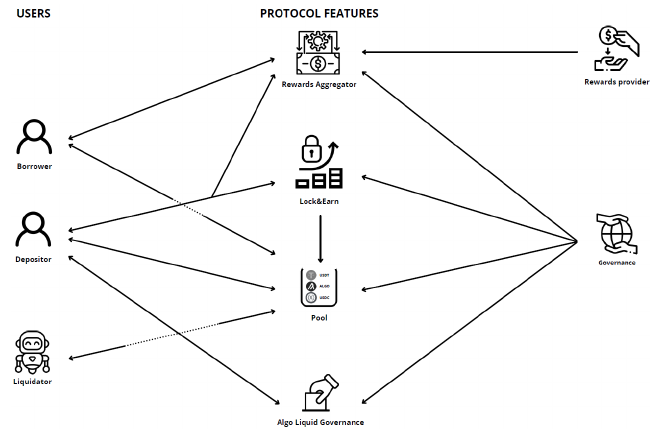
Figure 1 . Interactions between Folks Finance’s